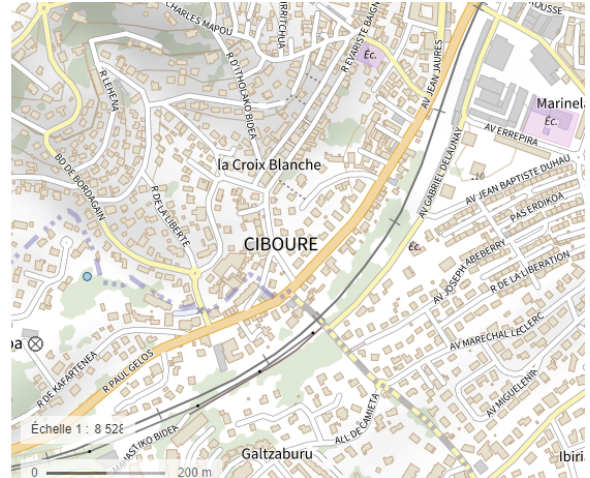
Figure 1. Extract of Plan IGN, inspiration for our target